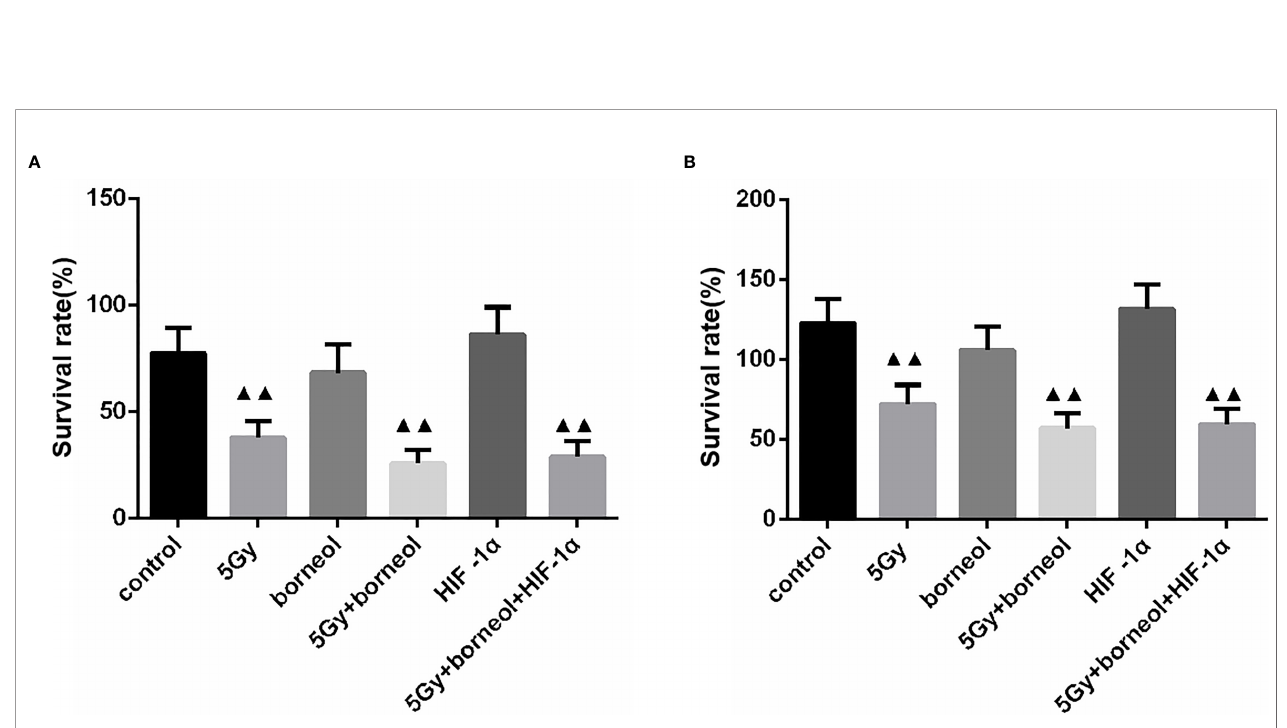
FIGURE 5 | Cell growth Of borneol and radiotherapy treatment on HIF-1 a silence (A) or overexpressing (B) cell ( (cid:1) x ± S, n =3). Compared with the control group, ▲▲ P <0.01.